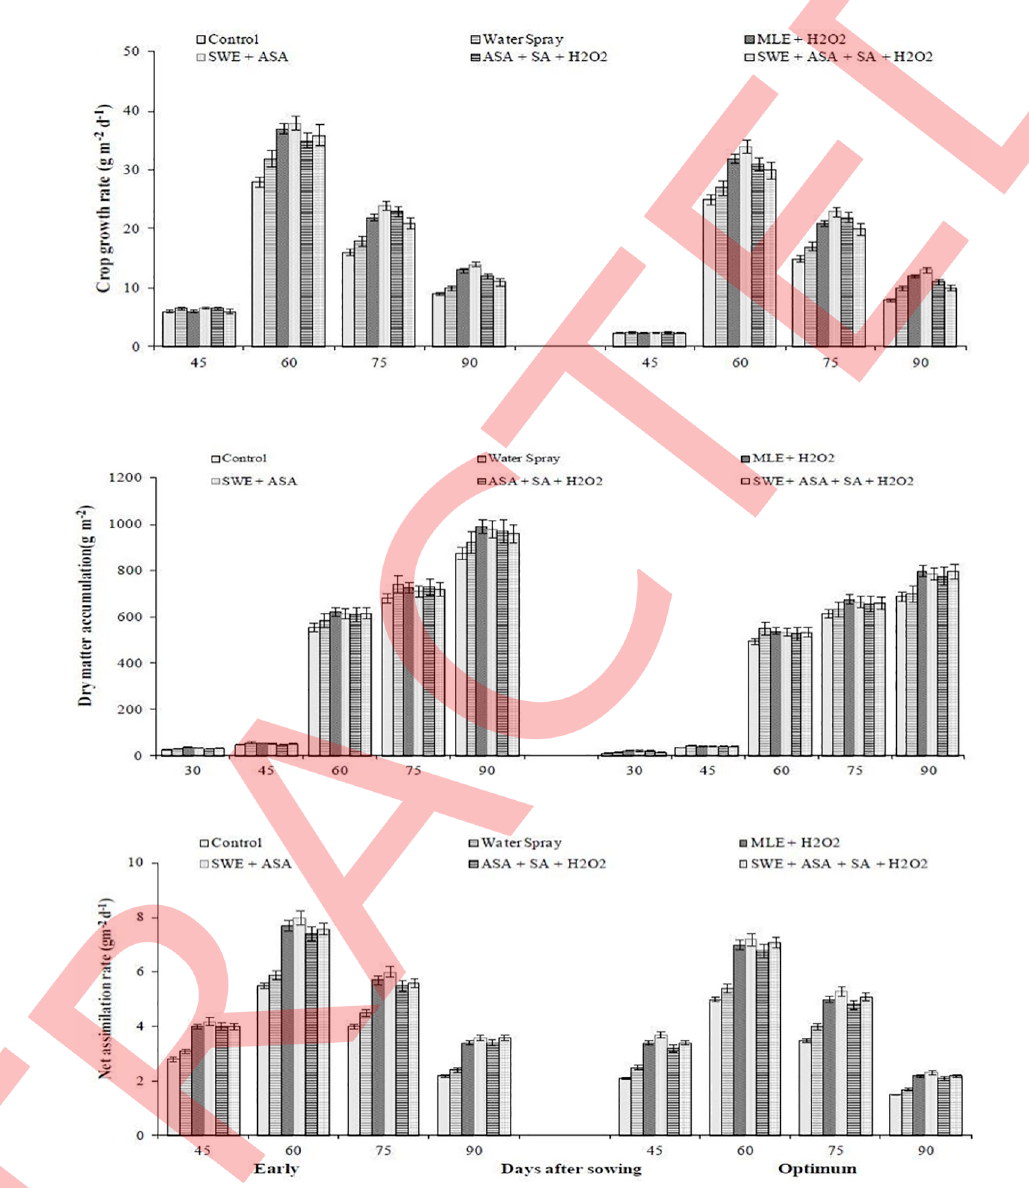
Fig 1. Growth of maize influenced by foliar applied growth promoting agents and sowing